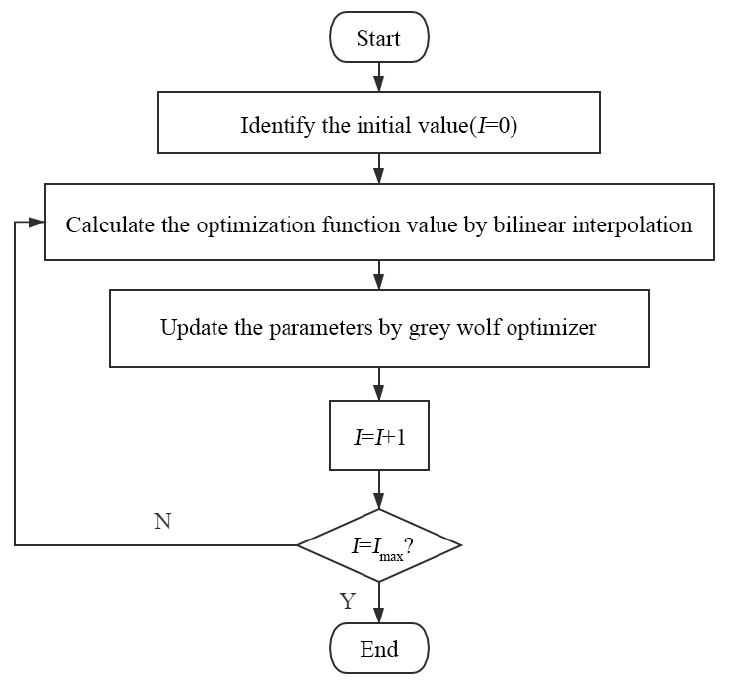
Figure 13. Flowchart of the optimization progress.